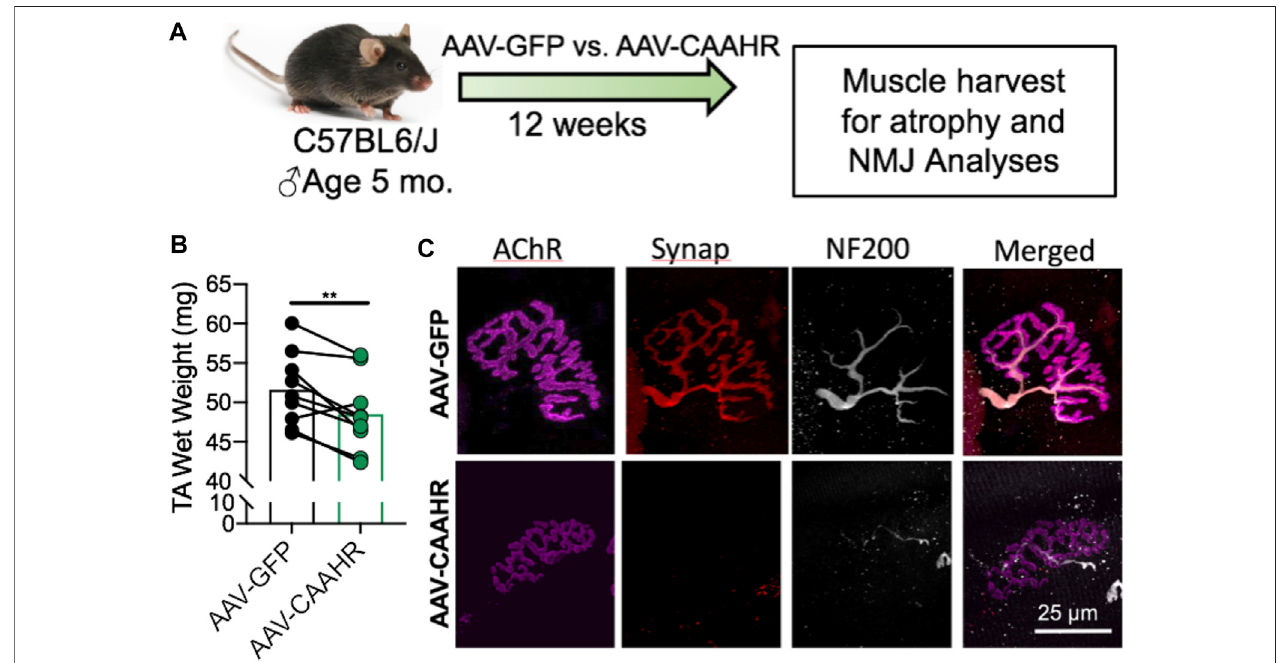
FIGURE 10 | COPD skeletal muscle exhibits several traits that resemble accelerated aging, including exacerbation of (A) atrophy (schematic image of an MRI through the thigh showing skeletal muscle, adipose tissue, bone), (B) mitochondrial dysfunction, and (C) accumulation of muscle fi bers expressing markers of denervation (e.g., neural cell adhesion molecule [NCAM] expression). Image showing NCAM labeling adapted from (Kapchinsky et al., 2018).